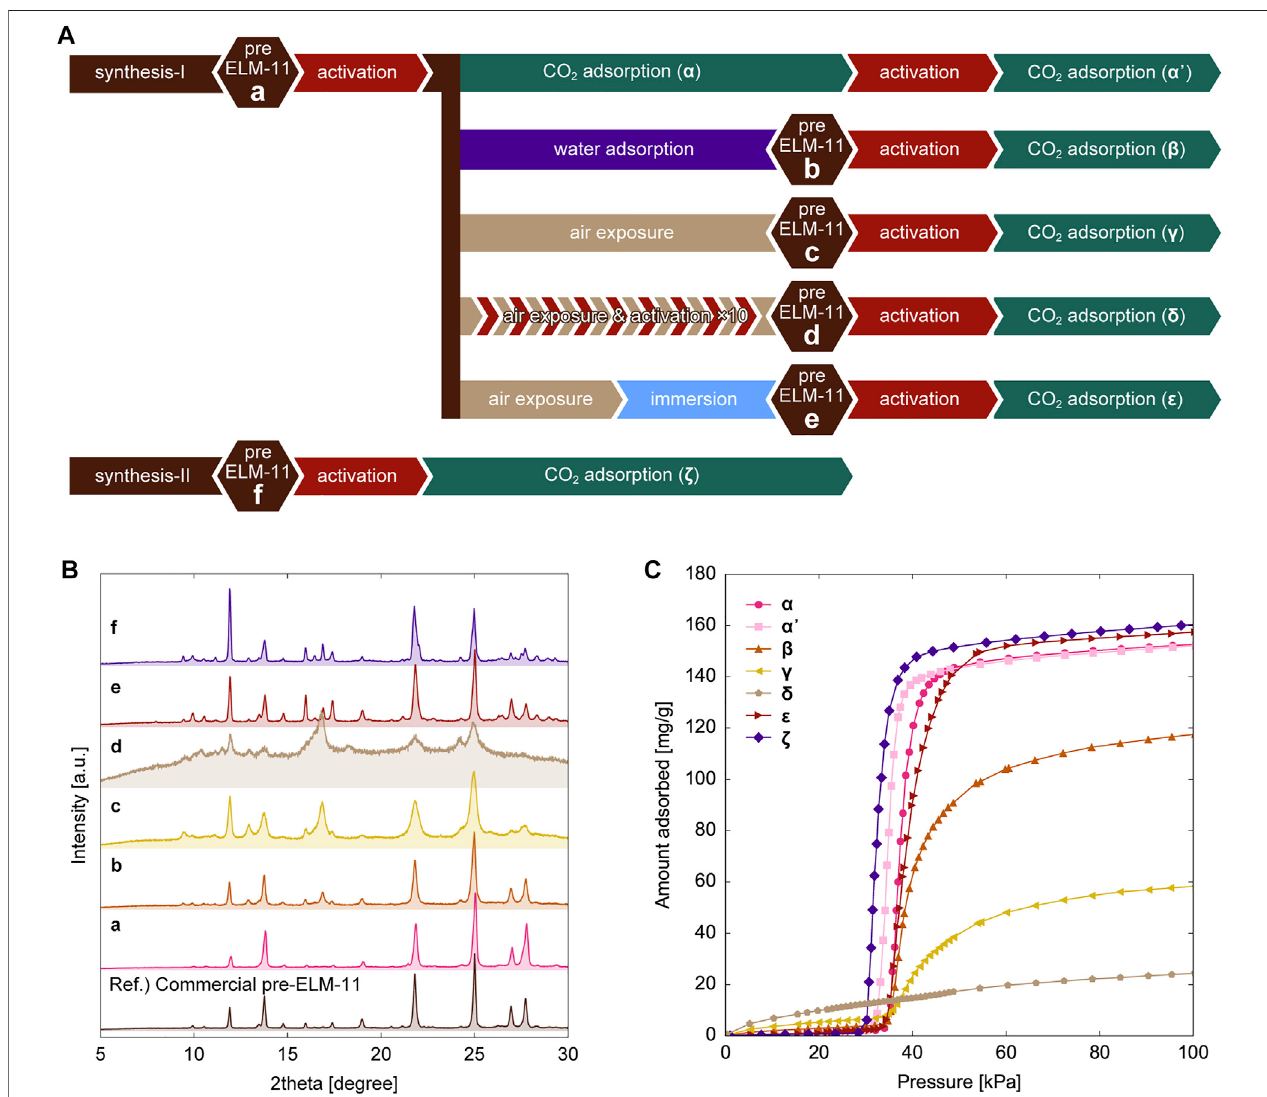
FIGURE 1 | (A) Classi fi cation of ELM-11 samples with different treatment procedures and synthetic conditions, (B) XRD patterns with labels from a to f which correspond to those in A and (C) adsorption isotherms of CO 2 at 273 K in samples with labels from α to ζ which correspond to those in A.